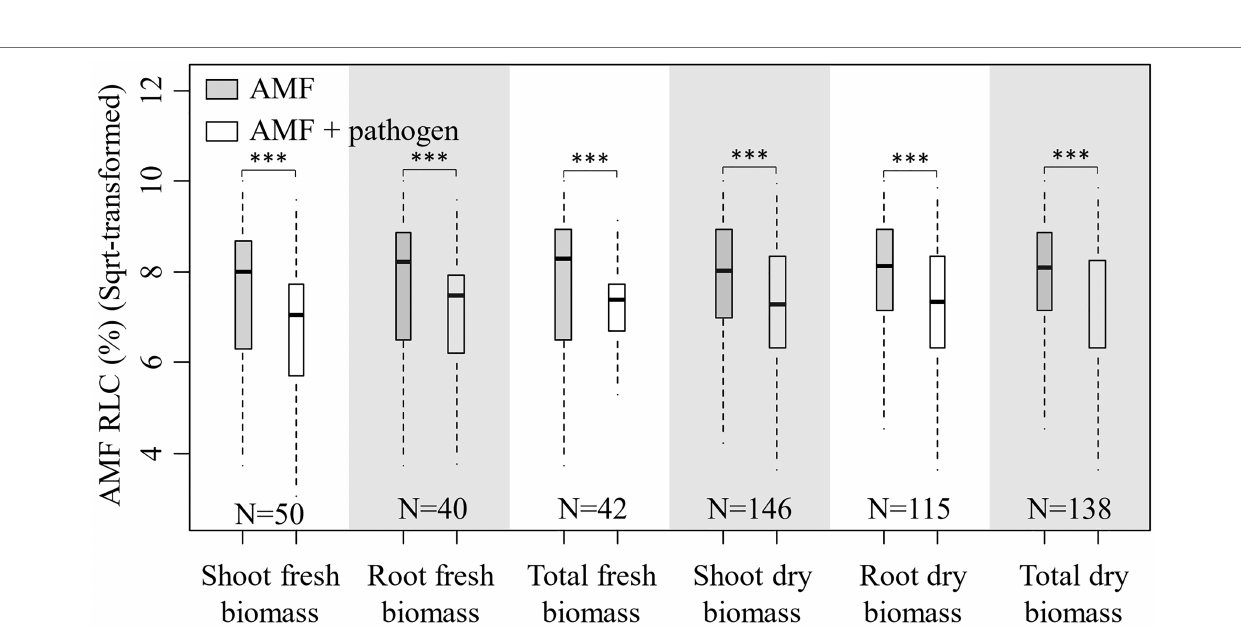
FIGURE 2 | Boxplot for root length colonization (RLC; sqrt-transformed) of AMF inoculation and AMF + pathogen inoculation treatments for each sub-database. Paired T test is used to calculate the significant difference: *** p < 0.001. N is the number of observations used for paired T test.